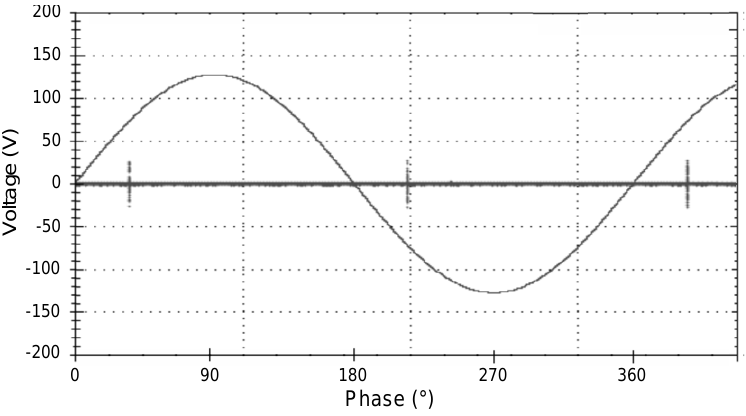
Figure 13. Phase resolved partial discharge (PRPD) in laboratory test.